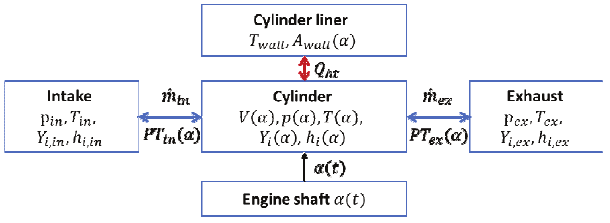
Fig. 5. Diagram of developed simple thermodynamic 0D model